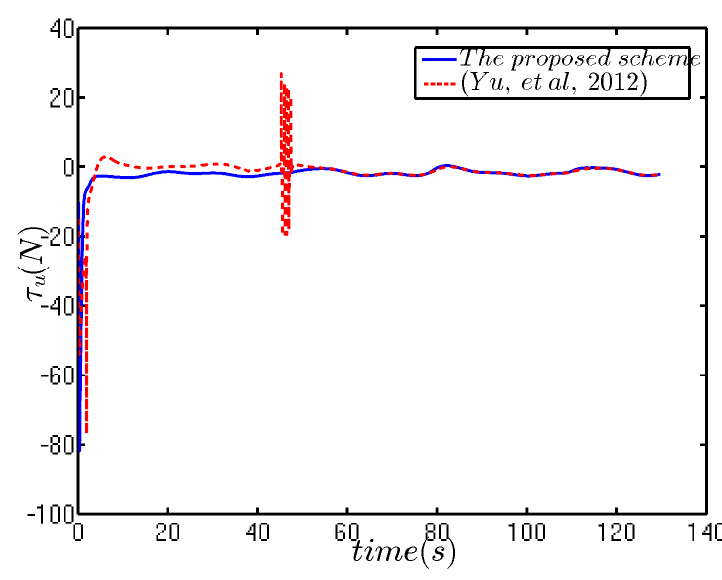
Figure 5. Comparison results of τ u .